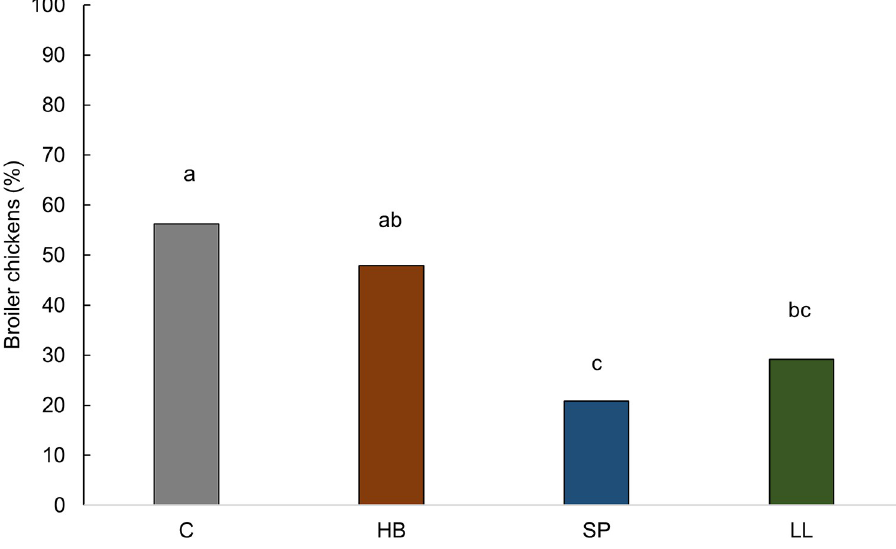
Fig 8. Proportion (%) of broiler chickens with subclinical spondylolisthesis score 1 (vertebrae compressed the bone marrow) at 43 days of age, n = 192. C = control, HB = hay bales, SP = step platforms, LL = laser lights. Bars without a common superscript ( a–c ) differed at P <